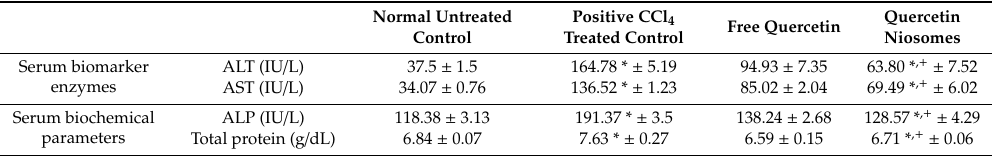
Table 3. Measured parameters of rats with CCl 4 -induced